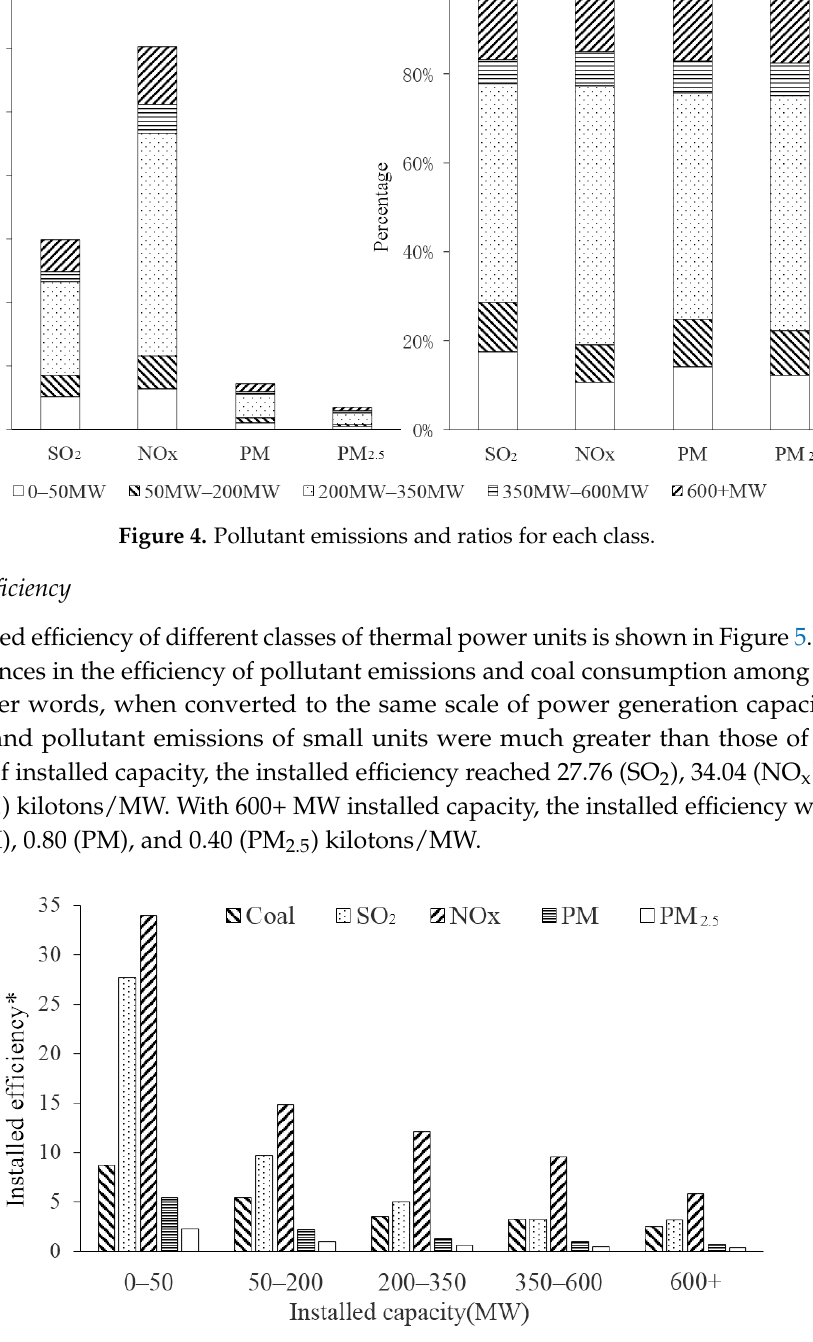
Figure 5. Installed capacity. * The unit of installed efficiency for coal consumption is 10 3 ton/MW, and the unit of installed efficiency for pollutants is ton/MW.